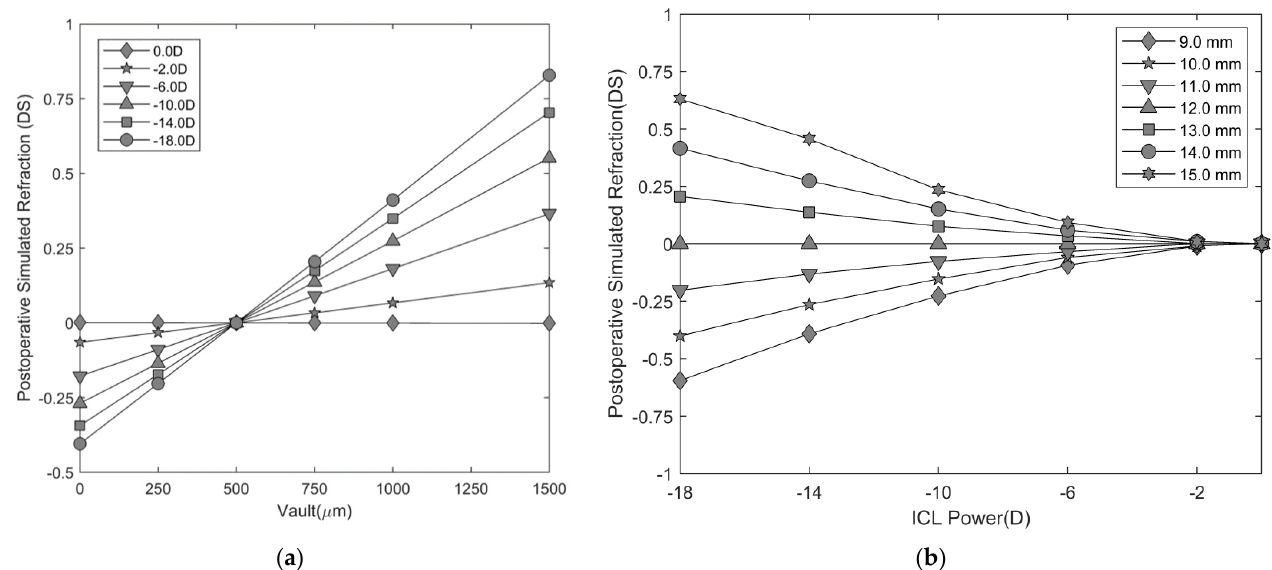
Figure 5. ( a ) Postoperative simulated refraction prediction as a function of vault size, for a series of myopic ICLs. The symbols represent the following refractive conditions at the spectacle plane ( (cid:117) : 0.00 DS, (cid:70) : − 2.00 DS, (cid:72) : − 6.00 DS, (cid:78) : − 10.00 DS, (cid:4) : − 14.00 DS, • : − 18.00 DS). ( b ) Postoperative simulated refraction prediction as a function of ICL power for various cornea-to-spectacle plane distances (vertex distance). ICL power calculation was performed for a set of refractive powers: 0.00 DS, − 2.00 DS, − 6.00 DS, − 10.00 DS, − 14.00 DS and − 18.00 DS, for a vertex distance of 12.0 mm. The symbols represent the following vertex distances used for refraction ( (cid:117) : 9.0 mm, (cid:70) : 10.0 mm, (cid:72) : 11.0 mm, (cid:78) : 12.0 mm, (cid:4) : 13.0 mm, • : 14.0 mm, (cid:86) : 15.0